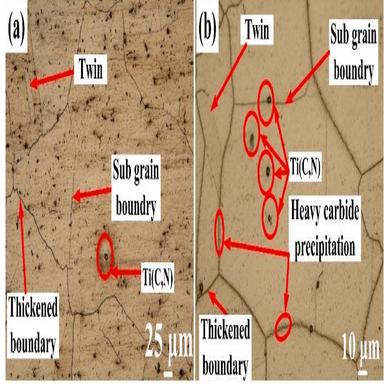
Optical micrographs of IN 800HT HAZ: (a) in AW state; (b) in PWHT state.